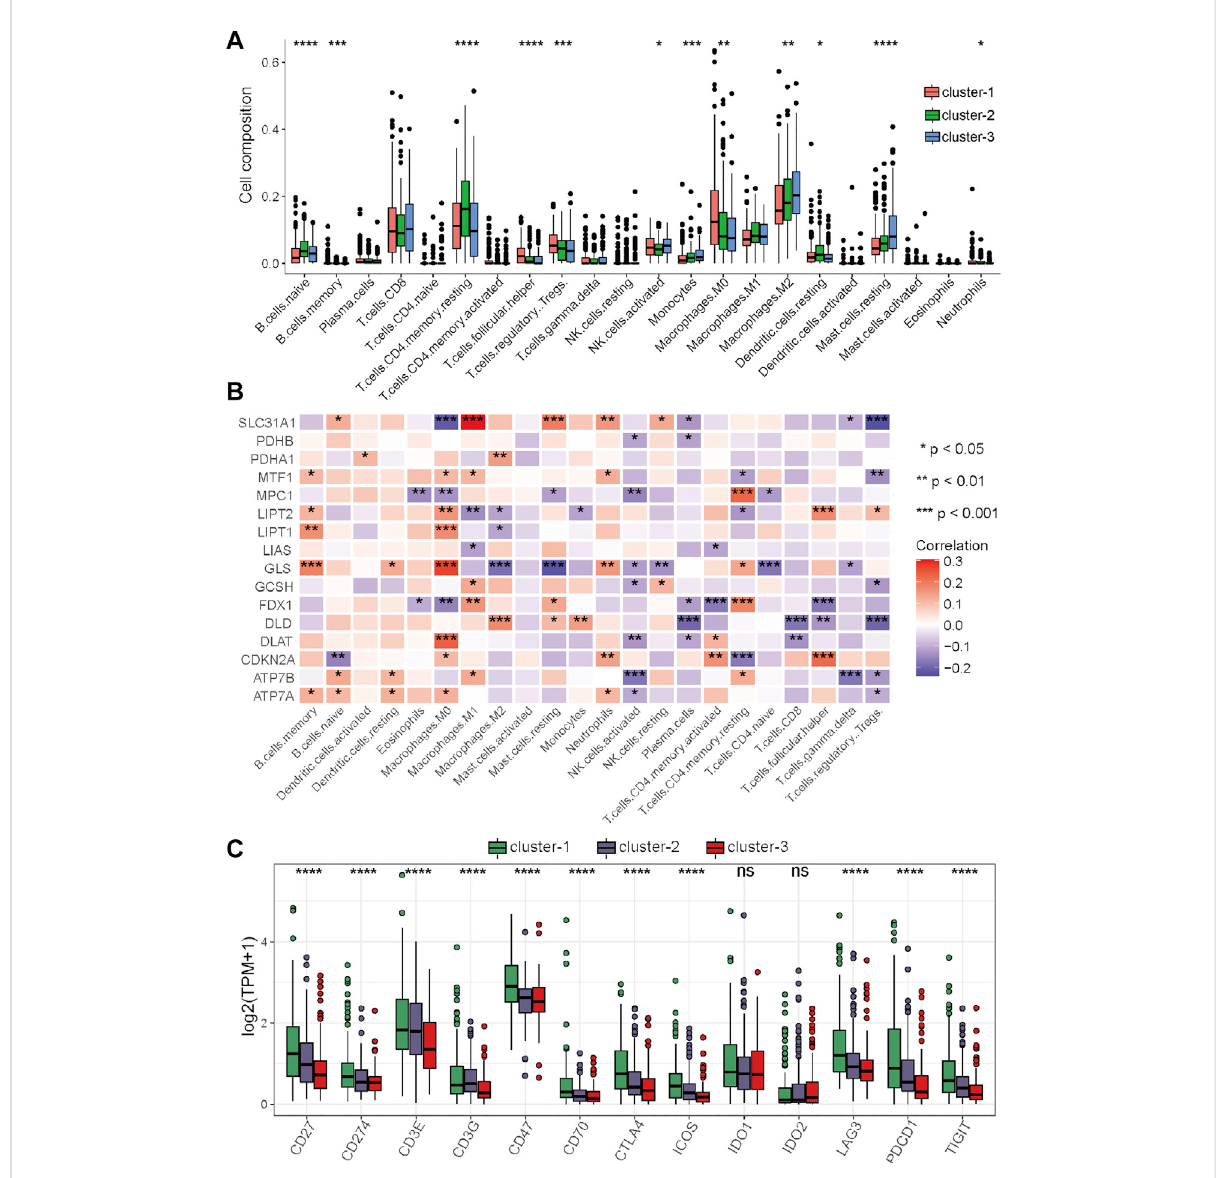
FIGURE 4 Differential analysis of immune characteristics among the three clusters in the TCGA – HCC cohort. (A) Differences in the 22 immune cell types among the three expression clusters. (B) Correlations between the 16 cuproptosis-related genes and 22 immune cells. (C) Differences in